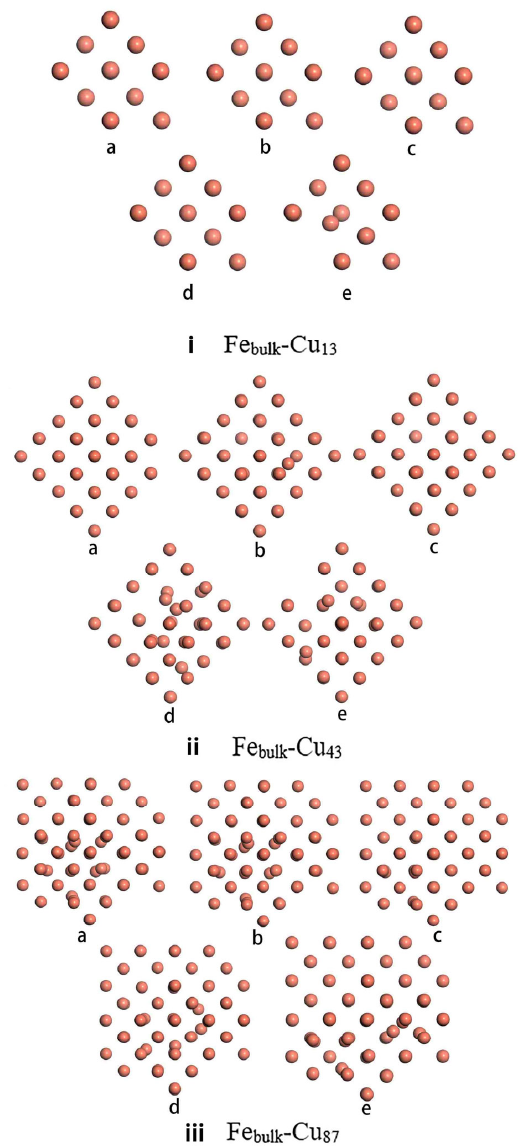
Figure 4. 2d projection of Cu cluster in the Fe bulk –Cu n system, n = 13 ( i ), 43 ( ii ) and 87 ( iii ) at a given temperature. ( a ) 400 K; ( b ) 500 K; ( c ) 600 K; ( d ) 800 K; ( e ) 900 K. When the Cu clusters change their configurations as the temperature increases, the Fe atoms in bulk present different features. As shown the Fe bulk in Figure 5i, at 400 K, there are some small strain zones. With the temperature increasing, positions and number of the strain zones changes. However, because there is a small number of Cu atoms at the BCC lattice positions, this small Cu 13 cluster does not affect the whole structure of the Fe bulk . For the Cu 43 cluster, as shown in Figure 5ii, a certain number of strain zones appear in the Fe bulk , and some of them are relatively large. As the temperature increases, the areas of some strain zones decrease significantly, whereas a few of zones grow large. In the meantime, segregation of solute atoms along the direction in (110) occurs. As the atom